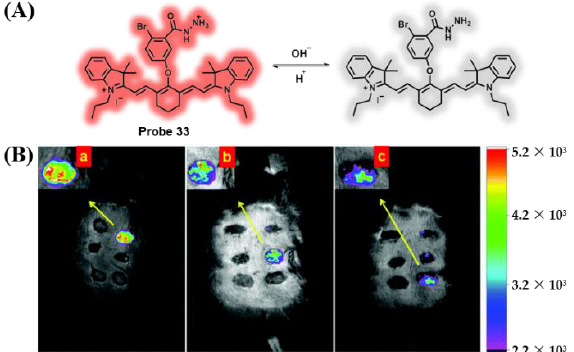
Figure 27. ( A ) Imaging mechanism of probe 32 ; ( B ) the fluorescence intensity within the wound beds at different times (i.e., day 1, day 4, and day 7) points was recorded using pseudo − color images. ( B - a , B - b ), and ( B - c ) are the partially enlarged views of the pseudocolor images, respectively. Adapted from Reference [130]. Copyright 2019, the Royal Society of Chemistry.